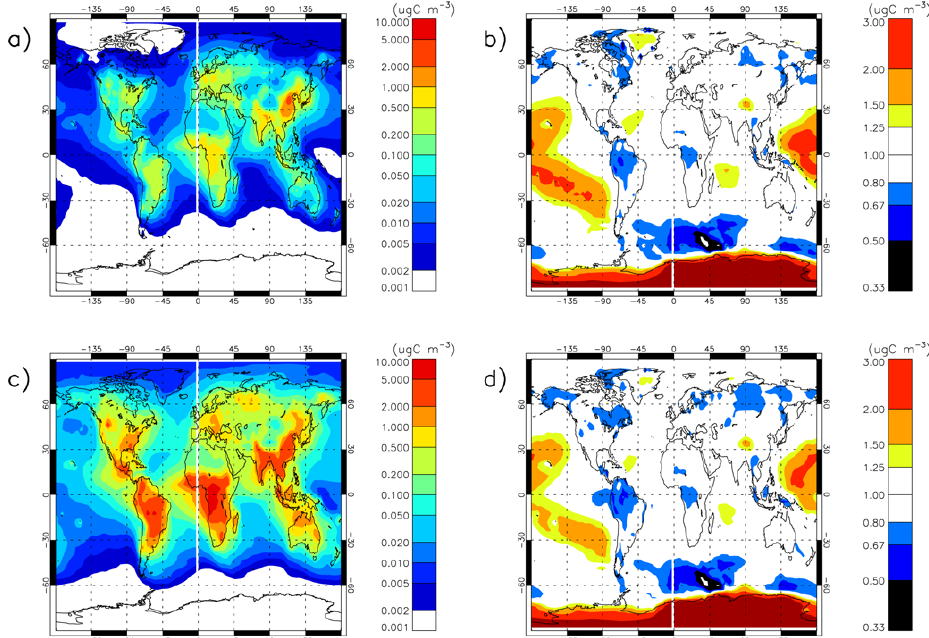
Fig. 6. Global surface maps showing (a) BC and (c) OC aerosol mass simulated by GLOMAP-mode (v6R) on the annual-mean. The ratio of GLOMAP-mode (v6R) to GLOMAP-bin simulated BC and OC are shown in panels (b, d) , respectively. Regions coloured yellow, orange and red in the relative bias maps indicate where GLOMAP-mode is higher than bin by 25–50, 50–100 and 100–200%, respectively, whilst light-blue, dark-blue and black indicate where bin is higher by the same proportions. Regions where the two schemes are within 25% are colored